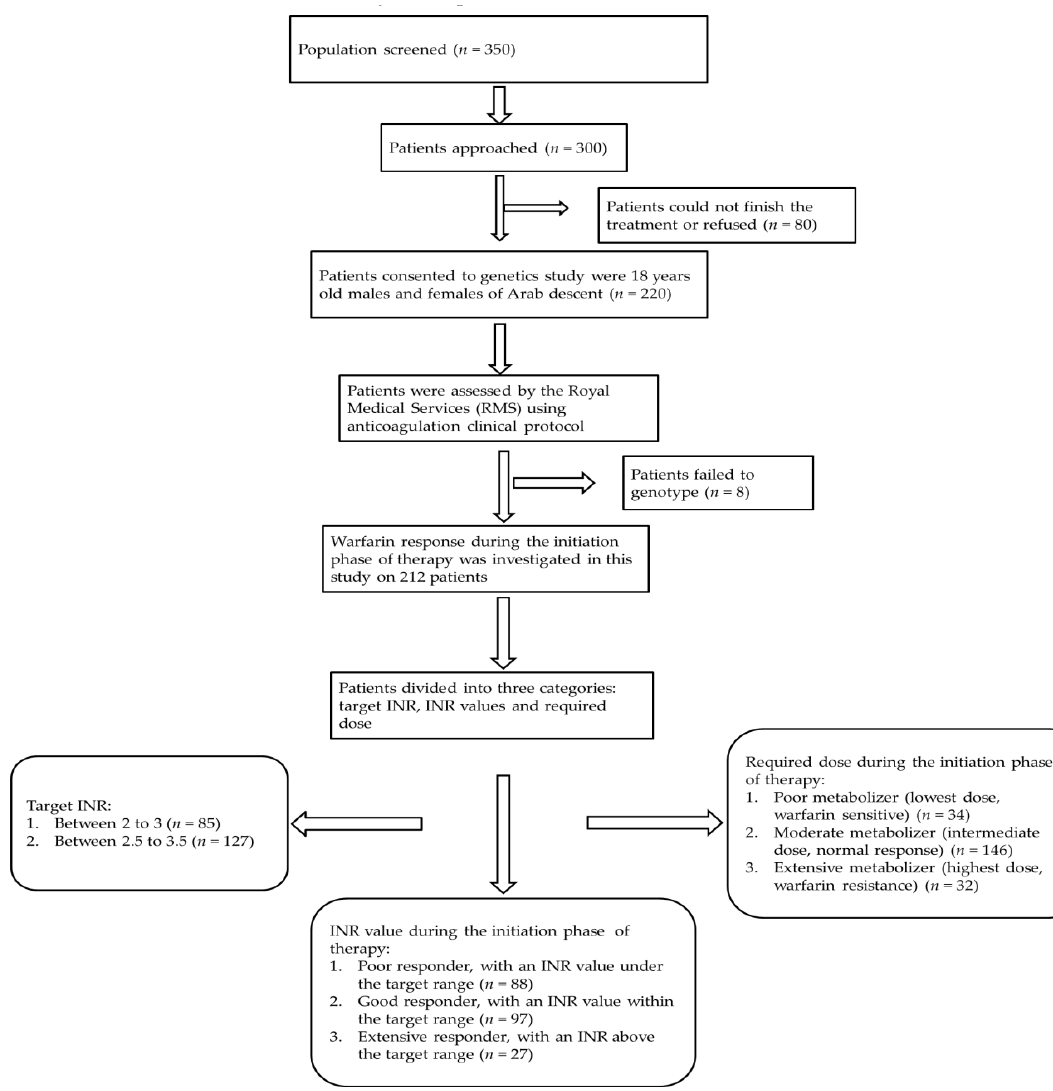
Figure 1. Flow chart depicting study design. INR: international normalized ratio 97